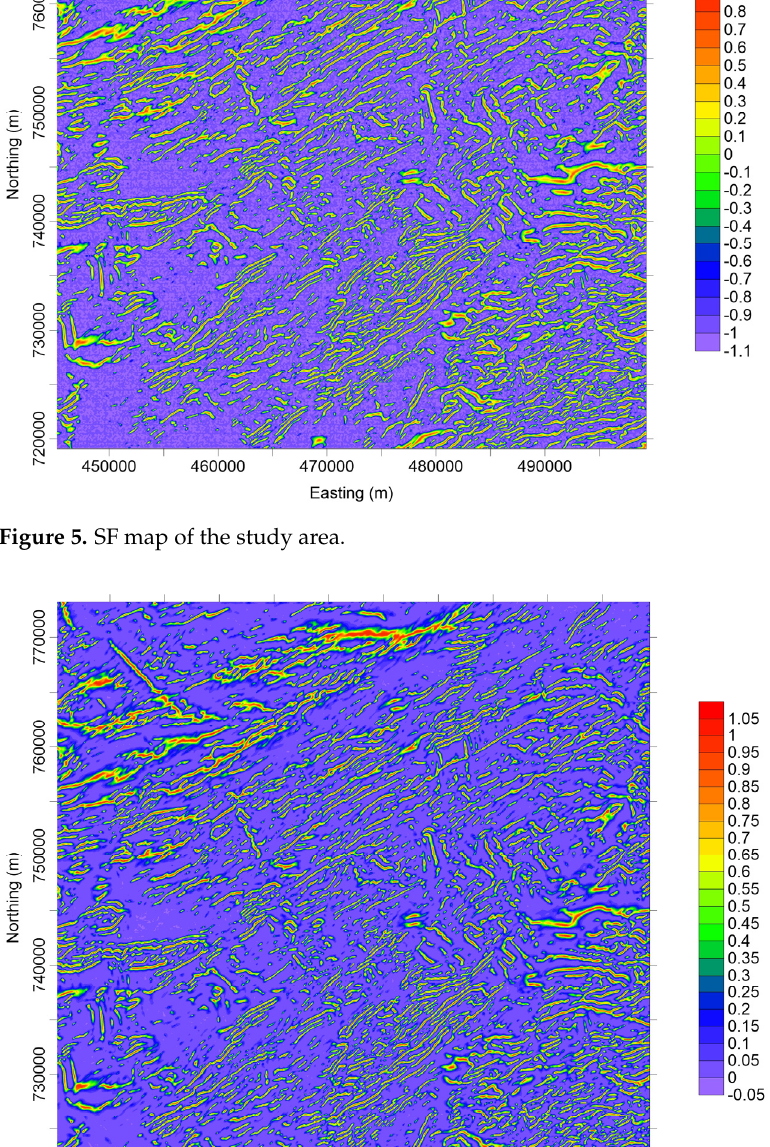
Figure 6. IL map of the study area.